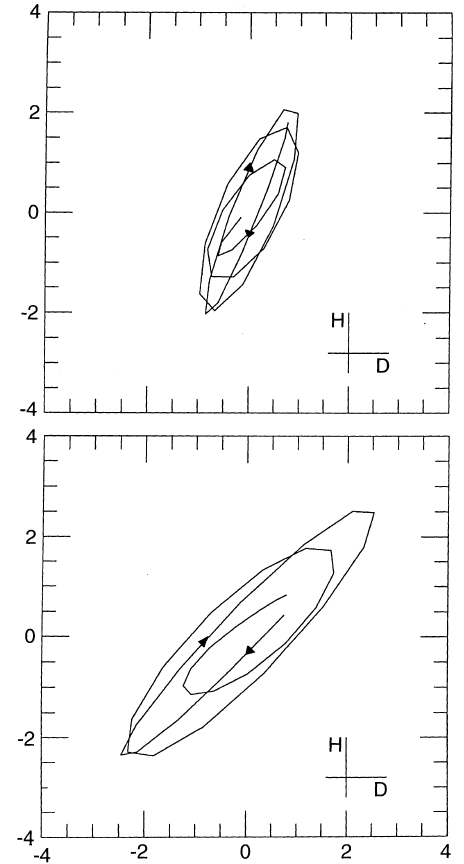
Fig. 3. The polarisation patterns for time interval 0925–1000 UT for the 1.4 mHz ( lower panel ) and the 1.8 mhz ( upper panel ) modes. Units are